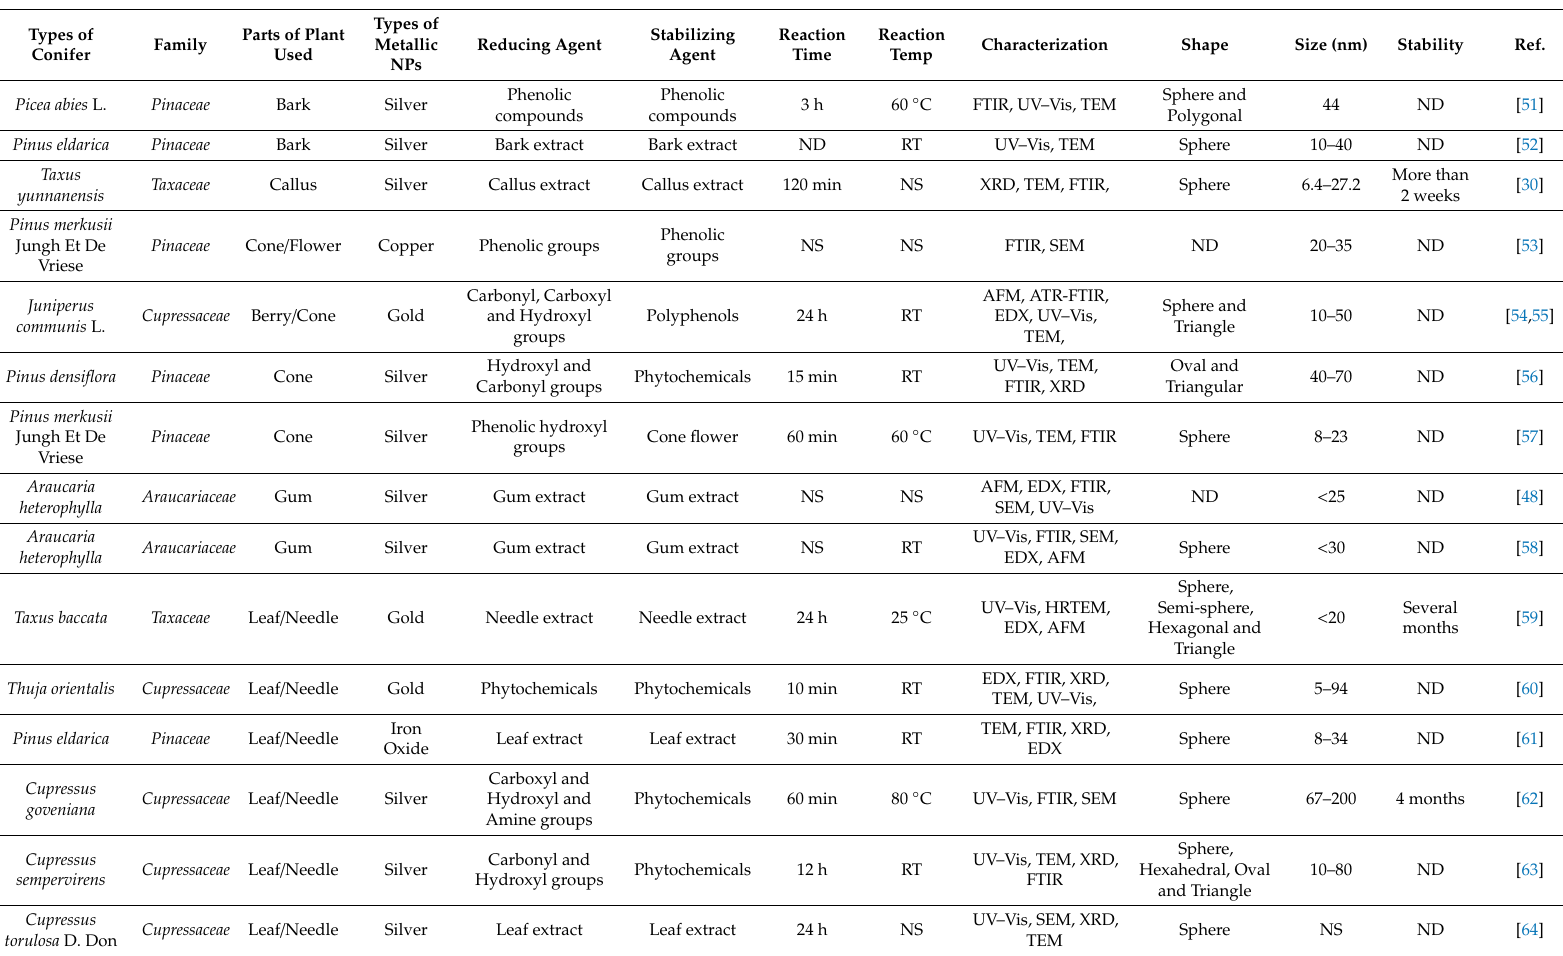
Table 1. Green synthesis of metallic nanoparticles synthesized from conifer extracts and their characterization through di ff erent analytical techniques. Types of